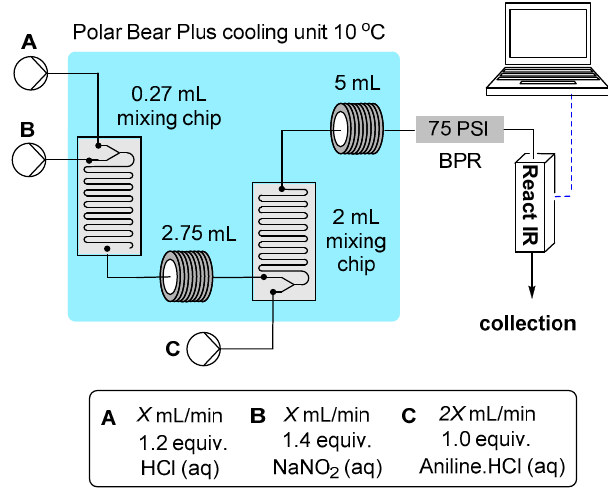
Table 1. Flow in situ formation of hydrazine derivatives from diazonium salts.